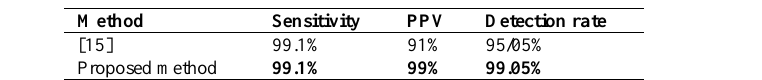
Table 9. Comparison between pedestrians’ detection rate in proposed method and related works on database